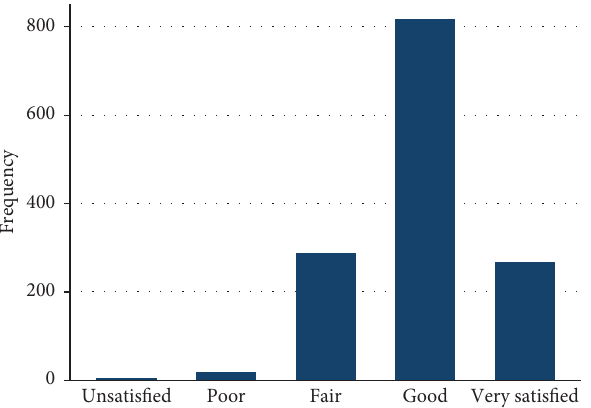
Figure 3: The frequency for passengers’ overall